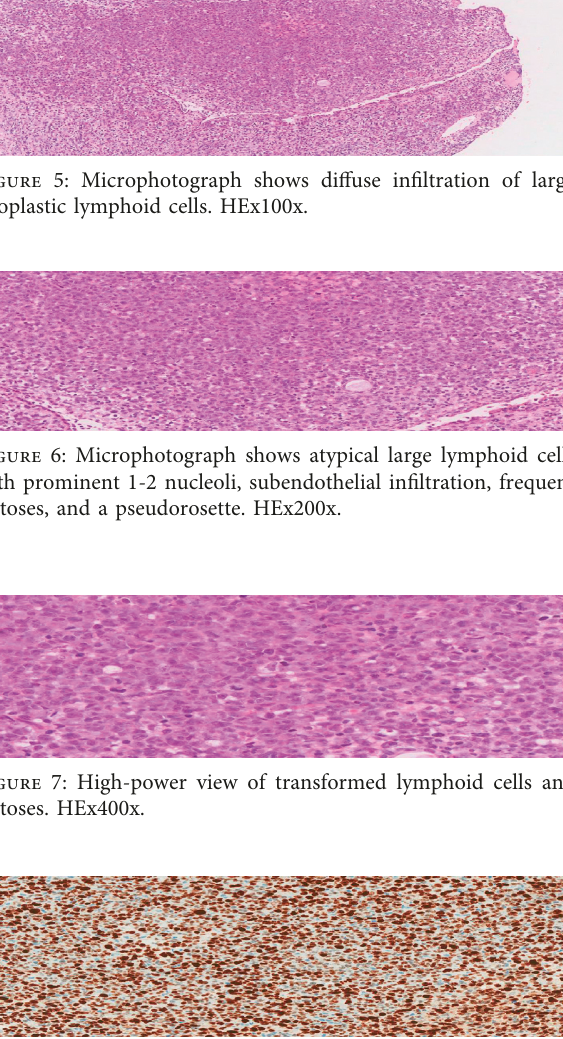
Figure 8: Ki67 by immunohistochemistry shows high proliferation index (80–90%). 200x.